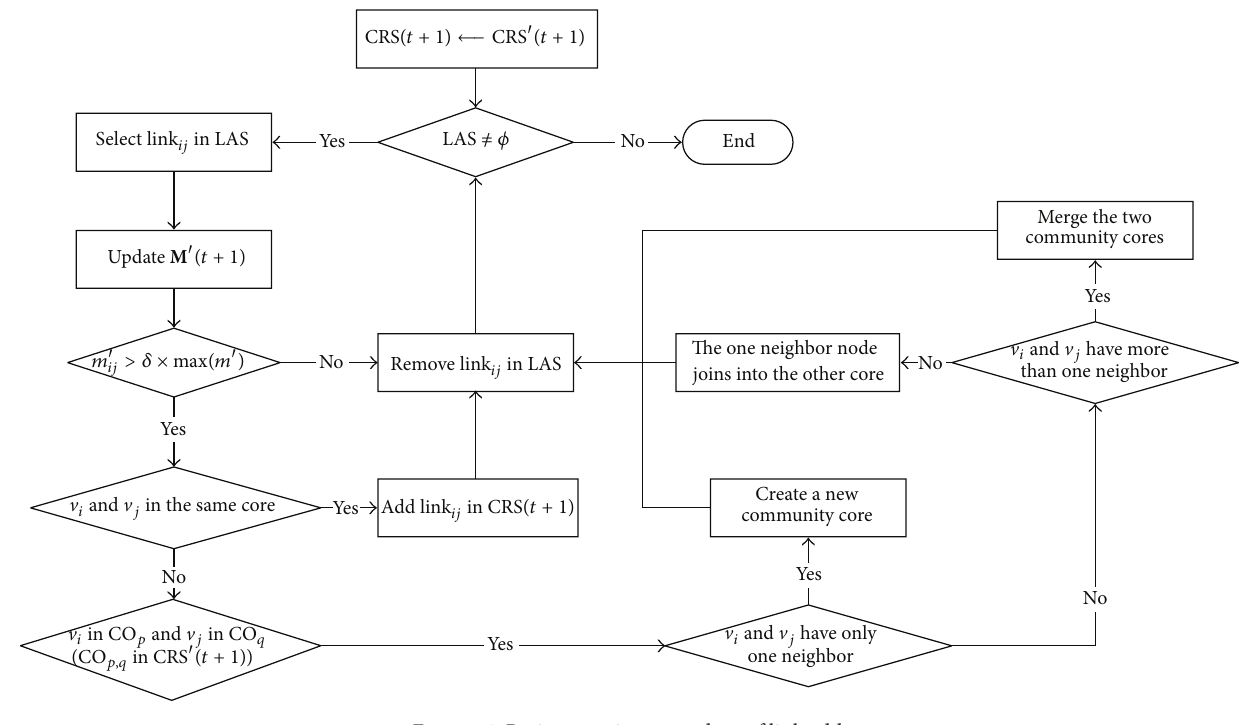
Figure 4: Basic operation procedure of link add.